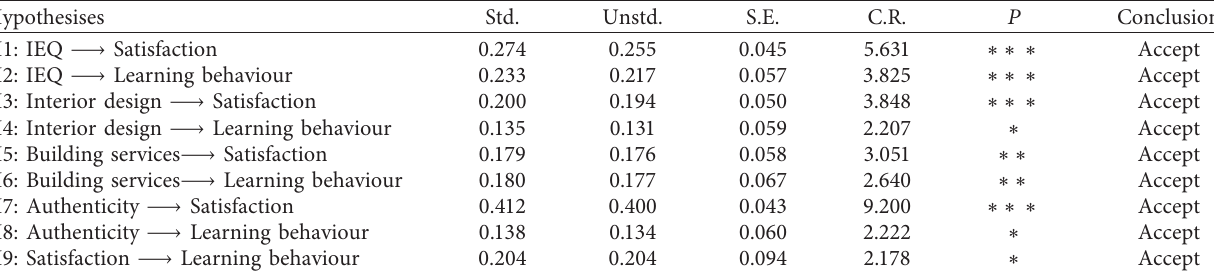
Table 8: Hypothesis model